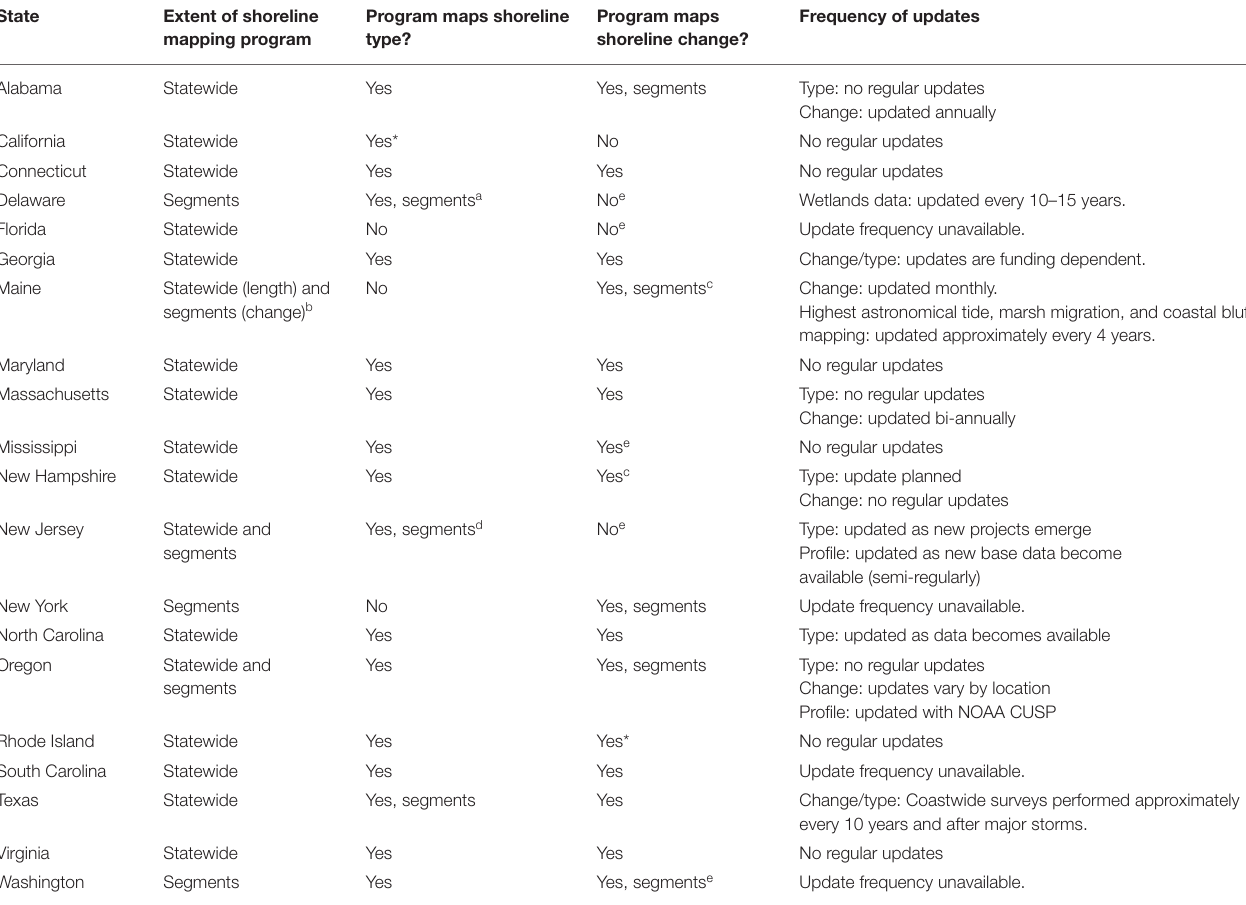
TABLE 1 | Summary of state-level shoreline mapping